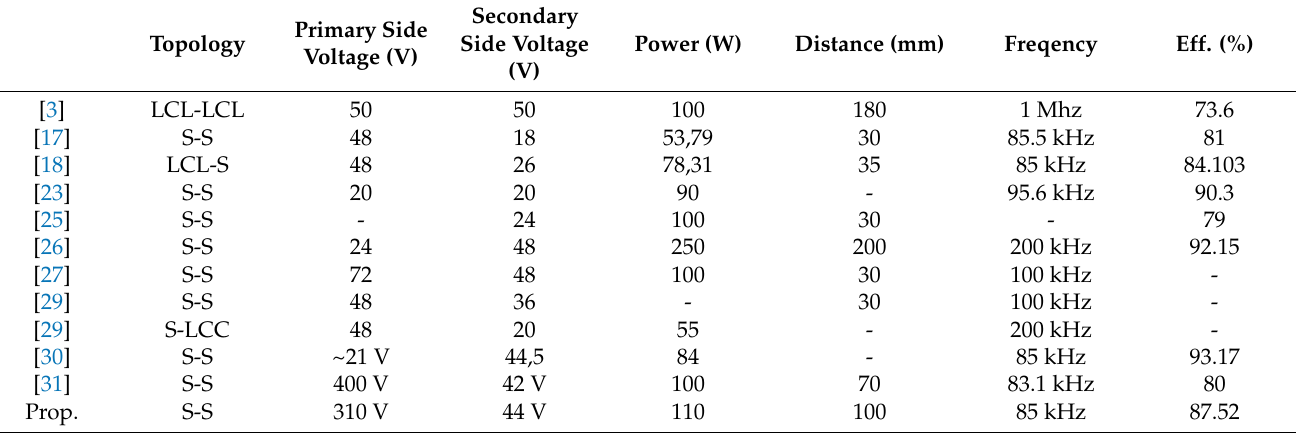
Table 3. The comparison of WCSs of similar power level.